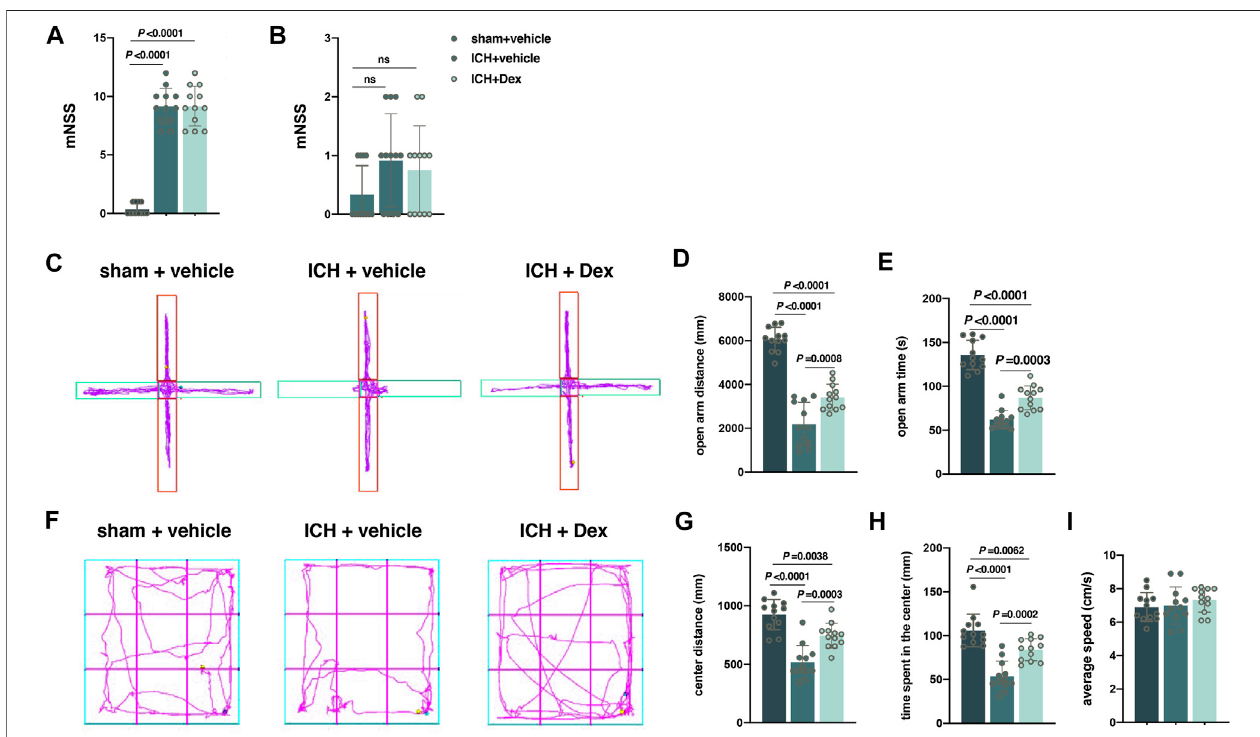
FIGURE 2 | Dexmedetomidine administration attenuated anxiety-like behaviors after ICH exposure. (A,B) Changes in the mNSS caused by the indicated stimuli 1 and 30 d post-ICH. (C) Computer printouts of shift trajectories in the elevated plus-maze test caused by the indicated stimuli 30 d post-ICH. (D,E) Distance and time in the open-arm during the elevated plus-maze test results caused by the indicated stimuli 30 d post-ICH. (F) Computer printouts of shift trajectories in the open- fi eld caused by the indicated stimuli 30 d post-ICH. (G – I) Distance and time in the central zone, and average speed during the open- fi eld test results caused by the indicated stimuli 30 d post-ICH. Data are presented as the mean ± SD ( n = 12). Sham, ICH, and Dex are described